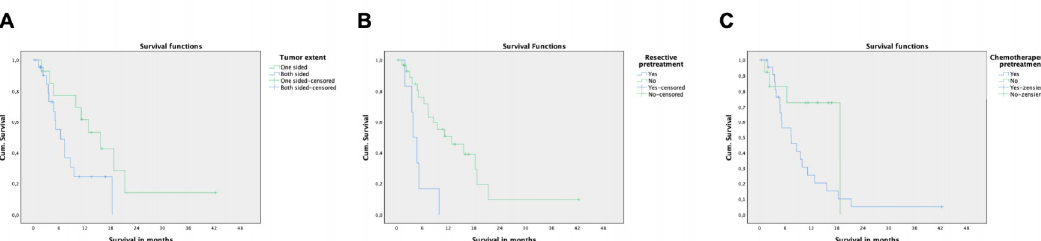
Figure 1. Kaplan–Meier Analysis of survival after 90 Y TARE. ( A ) Increased cumulative survival of patients with unilobar ( n = 17) versus bilobar ( n = 29) disease ( p = 0.042). ( B ) Increased survival of patients without previous resective surgery ( n = 28) compared to patients who have undergone previous resection ( n = 9, p = 0.002); a total of n = 37 patients with su ffi cient follow-up data were included in the analysis. ( C ) Previous systemic therapy missed statistical significance as a prognostic factor in this cohort of